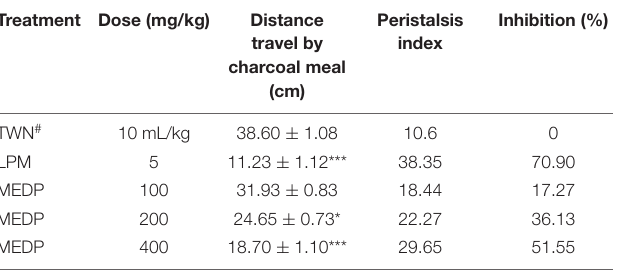
Effects of various test doses of MEDP on castor oil induced charcoal meal transit study in mice (n = 6). Values are presented as mean ± SEM; One-way analysis of variance (ANOVA) followed by Dunnett’s test. *p < 0.05 and ***p < 0.001 is considered as significant compared with the control, where # is designated as